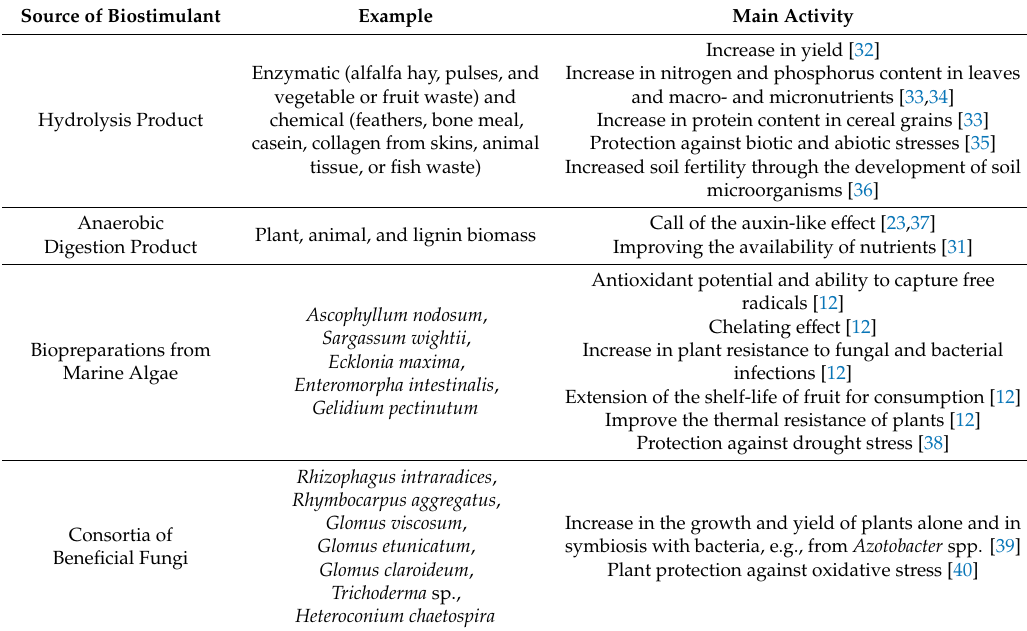
Table 1. Activity of di ff erent types of